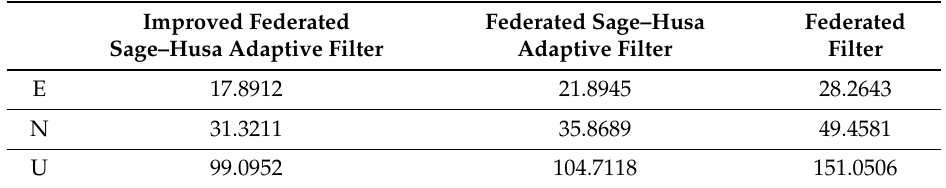
Table 5. Position error (m).